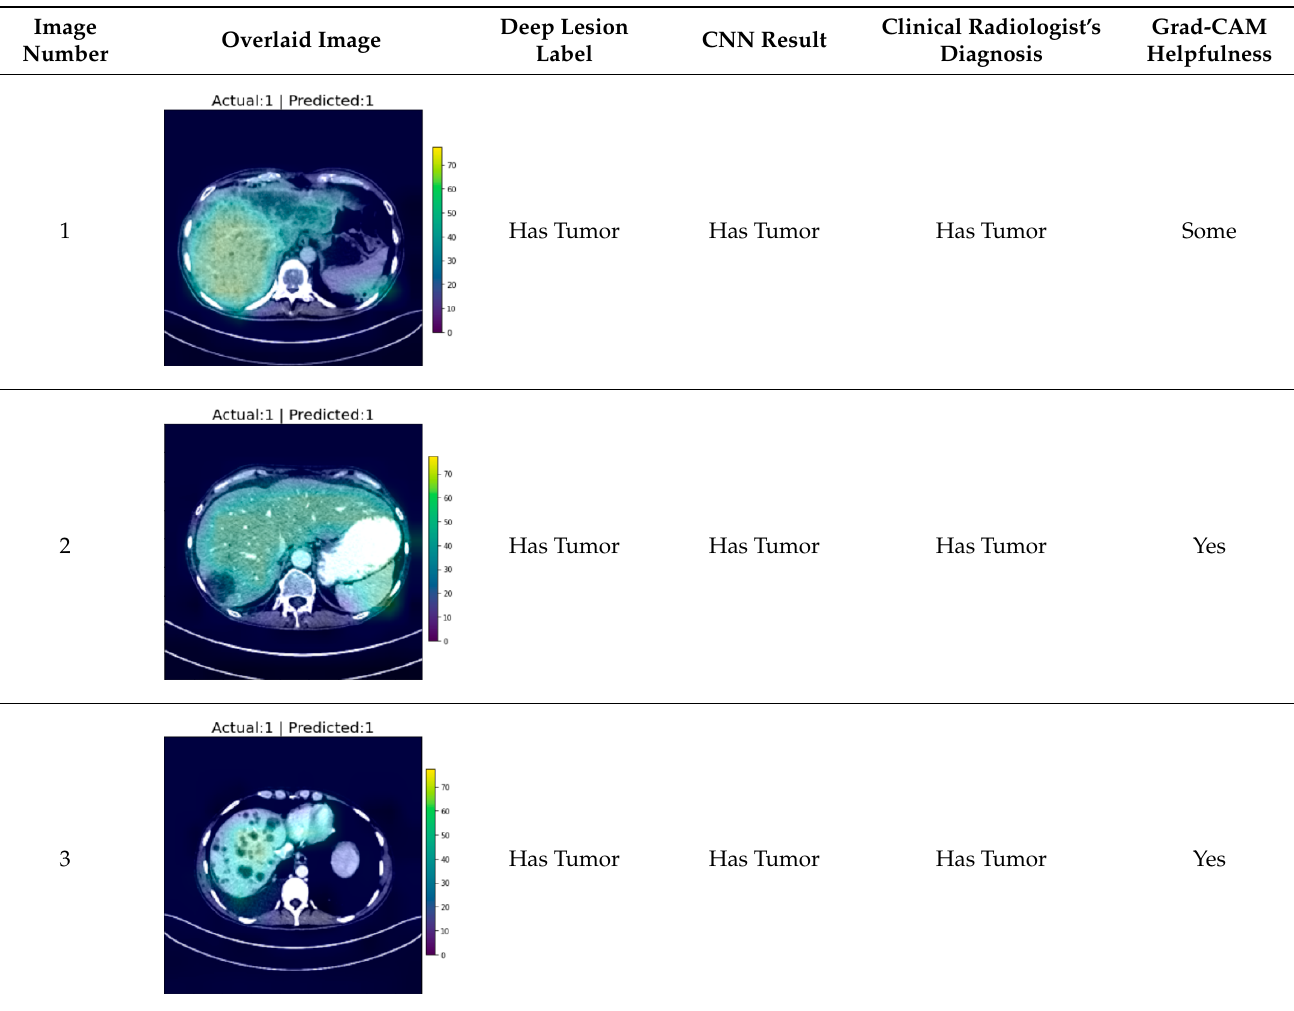
Figure 6. CT images with Grad-CAM-generated heat-maps overlaid.